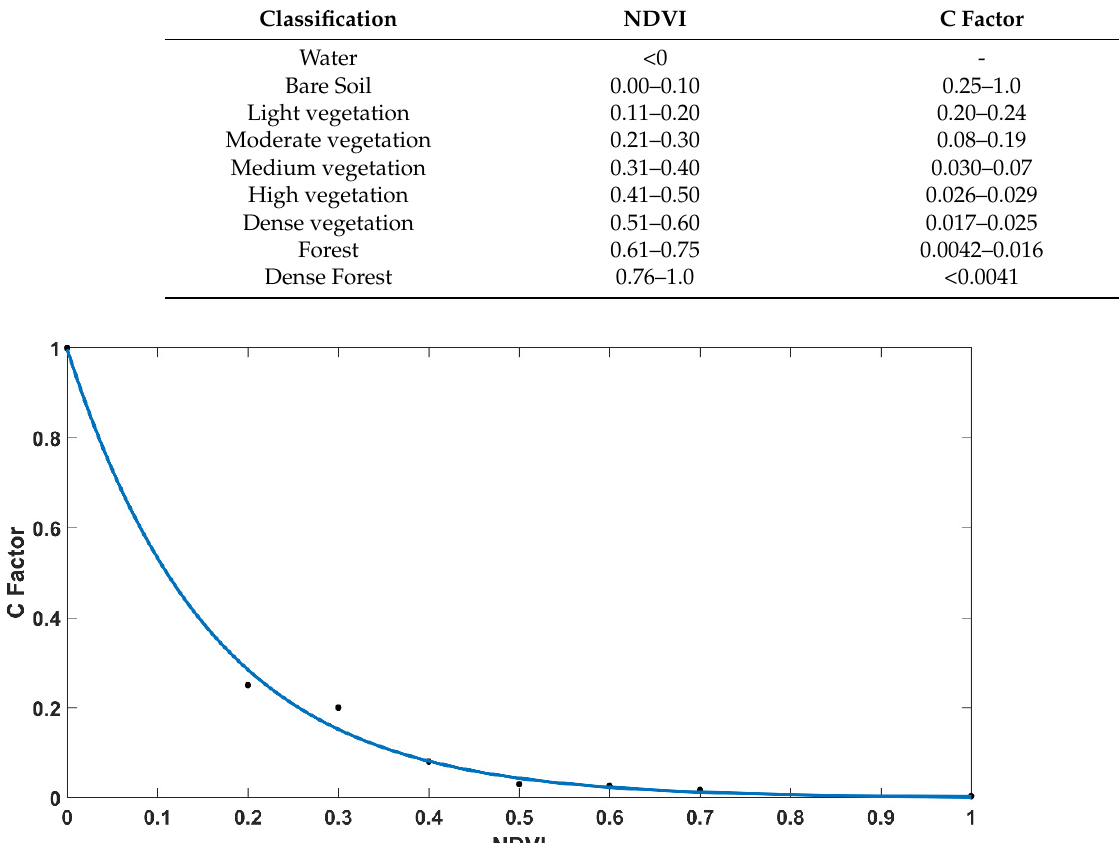
Figure 2. Relationship between the C factor and measured NDVI .